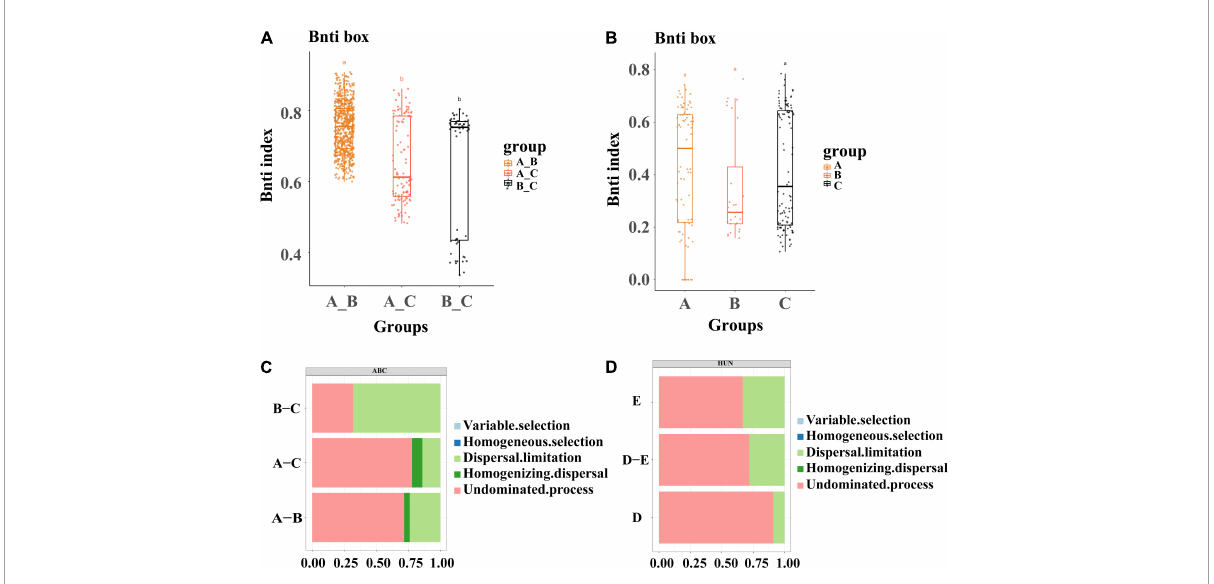
FIGURE5 Analysis of microbiota assembly process. (A) Microbial assembly analysis of 58 single strains, divided into three groups of A, B, and C, which are viewed as control groups. (B) Microbial community assembly analysis of 4 single bacteria and mixed bacteria, where D represents the combination of four single bacteria and E represents the combination of three groups of mixed bacteria. (C) Analysis of the causes of community aggregation and composition of 55 single bacteria and the control group (divided into three groups of A, B, and C, which are viewed as control groups). (D) Analysis of the reasons for the aggregation and composition of single bacteria and mixed bacteria in the mixed bacteria test, where D represents the combination of four single bacteria and E represents the combination of three groups of mixed bacteria. The letters above the bars represent the differences between